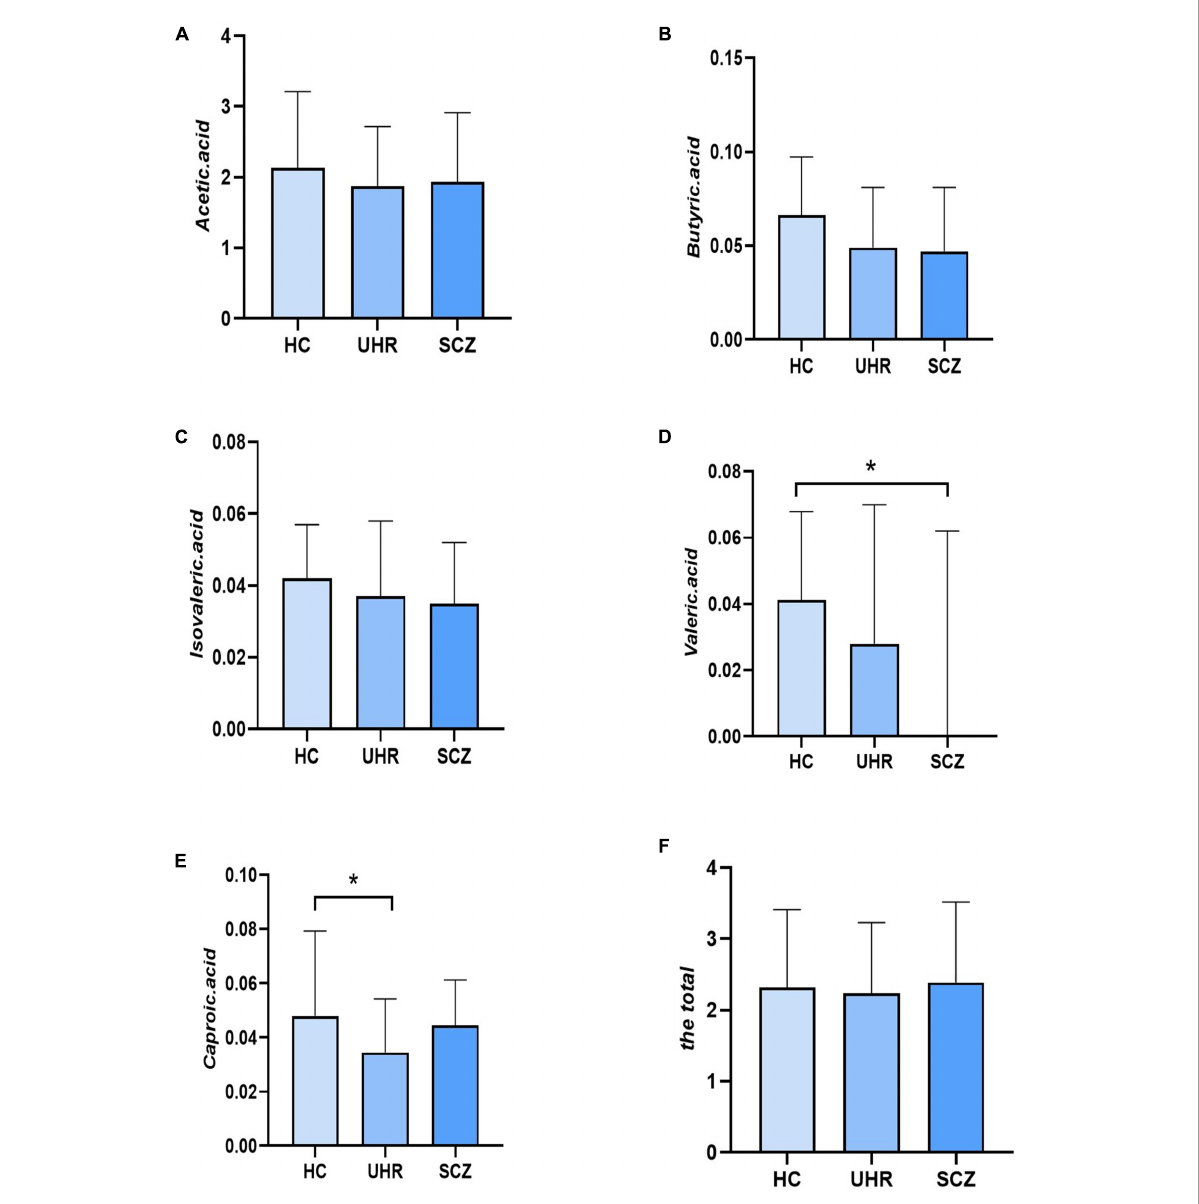
FIGURE1 The short-chain fatty acids (SCFAs) level comparison in healthy controls (HC) group, ultra-high-risk (UHR) group, and schizophrenia (SCZ) group. (A–F) Showed the comparison of acetic acid, butyric acid, isovaleric acid, valeric acid, caproic acid and the total SCFAs levels, respectively among Group HC, Group UHR and Group SCZ. * p <